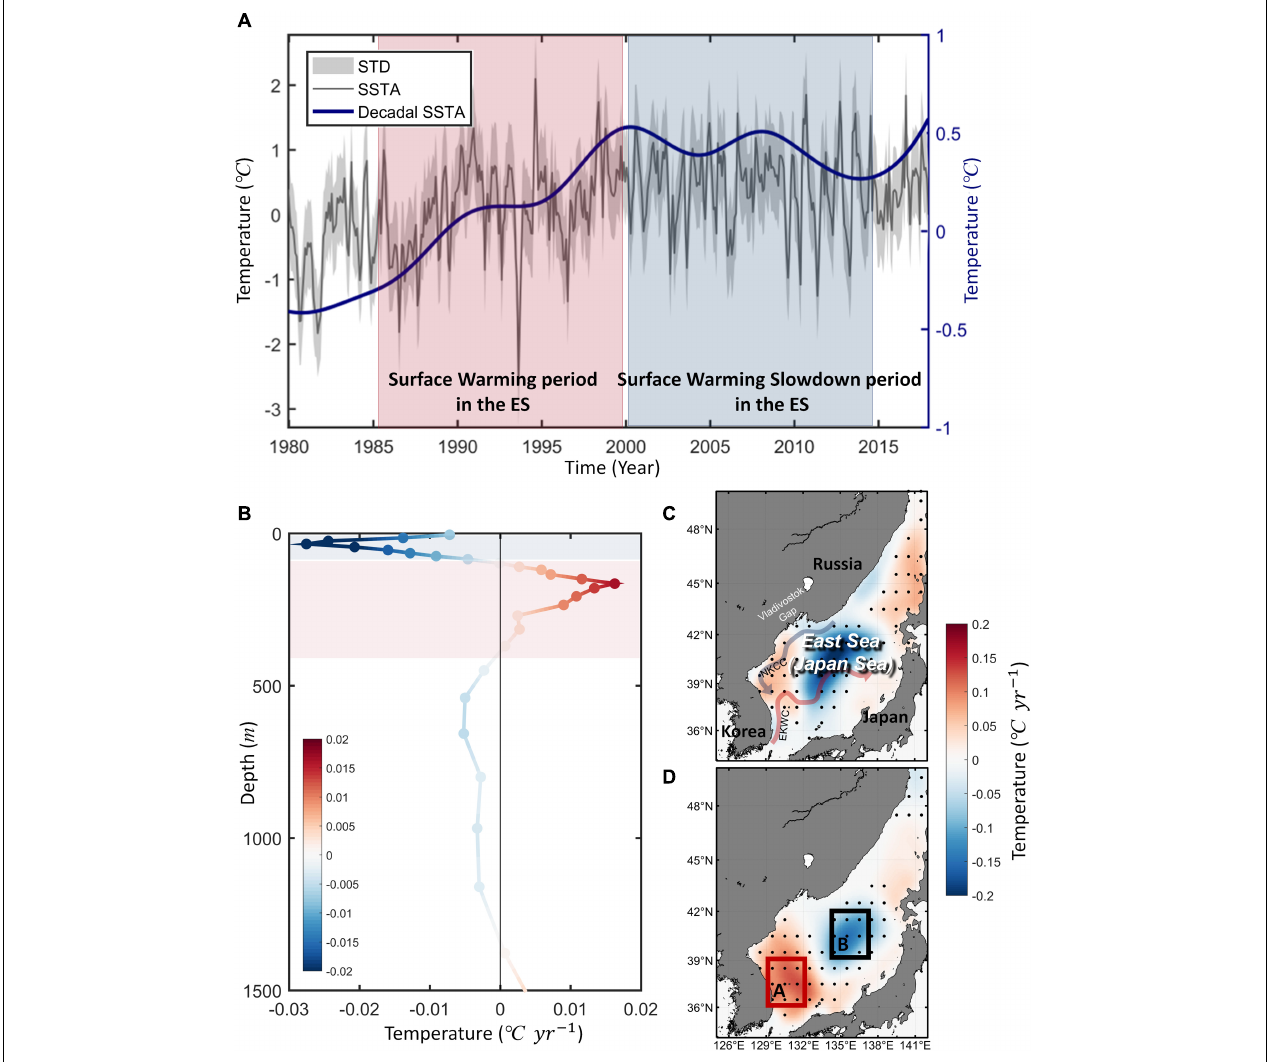
FIGURE 1 | (A) Timeseries of sea surface temperature anomaly (SSTA) in the ES (black line) and its decadal mode (blue line) highlighting periods of surface warming (red shaded) and surface warming slowdown (blue shaded). Shading with gray lines indicates the standard deviation of each month for the SSTA. (B) Vertical profile of long-term trend in monthly mean temperature anomaly from 2000 to 2014 at the upper 1,500 m of the ES, indicating cooling and warming trends at the upper 100 m (blue shaded) and 100–300 m (red shaded), respectively. The vertical black line in panel (B) shows where the trend is zero. Spatial distribution of the temperature trend (C) for the upper 100 m of the ES and (D) depths from 100 to 300 m during the SWS period. The red and gray lines show the East Korea Warm Current (EKWC) and the North Korea Cold Current (NKCC), respectively (C) . The red and black boxes indicate Regions A and B, respectively (D) . Black dots in panels (C,D) indicate where the trends are significant at the 95% confidence